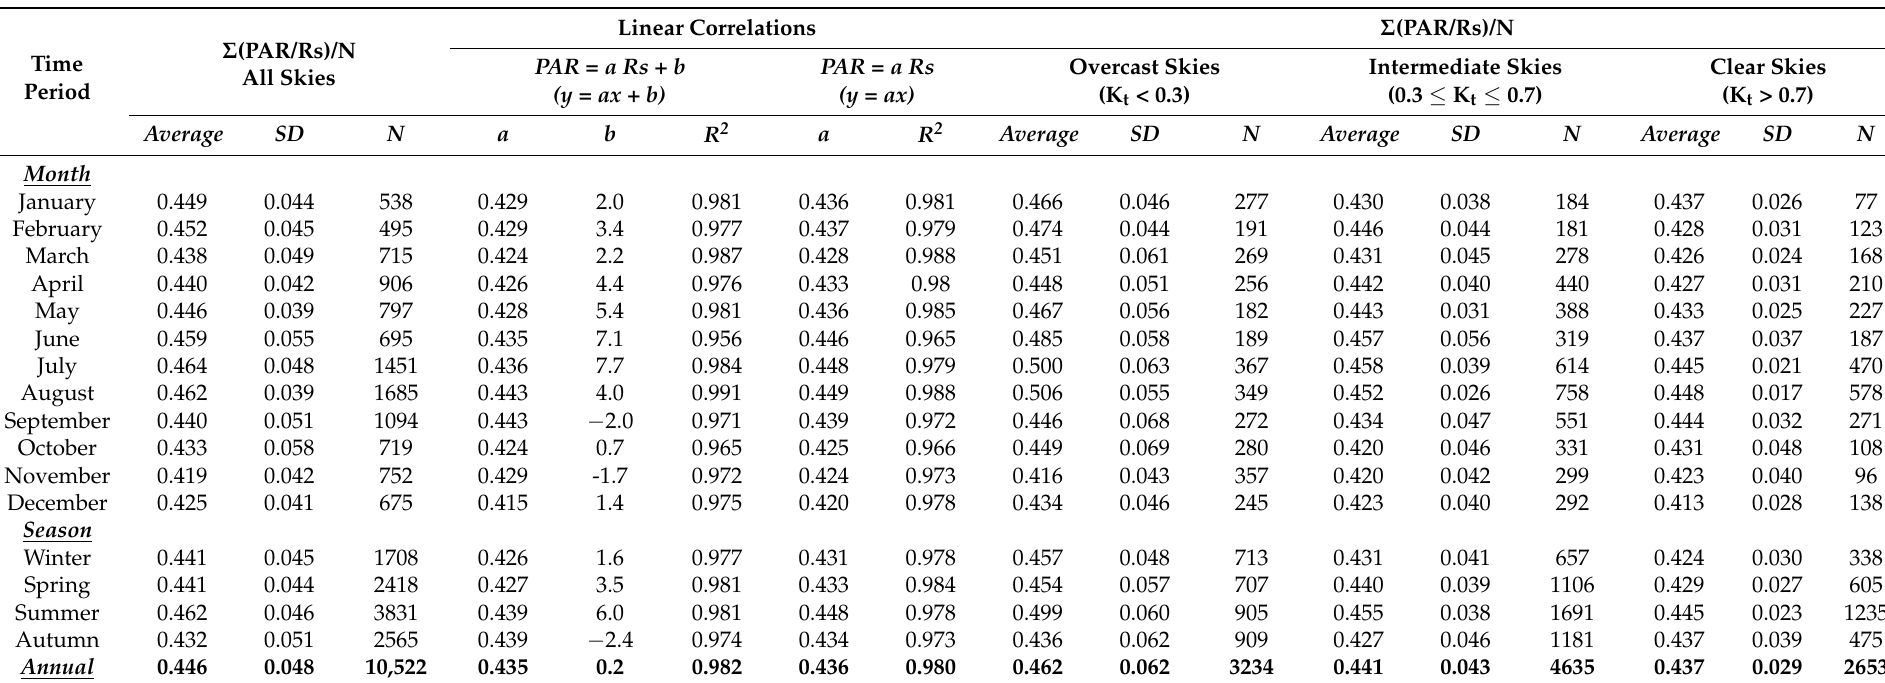
Table 2. Monthly, seasonal, and annual averages of the ratio PAR/Rs, number of hourly datasets (N) and standard deviations (SD) under deferent sky